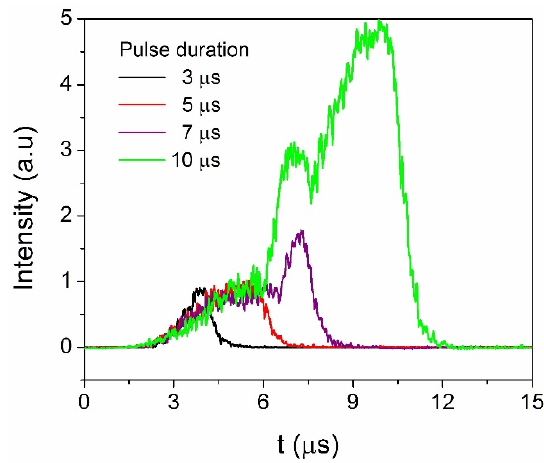
Figure 2. Typical waveforms of Ar + ( λ = 434.8 nm) spectral line intensity for different pulse durations.